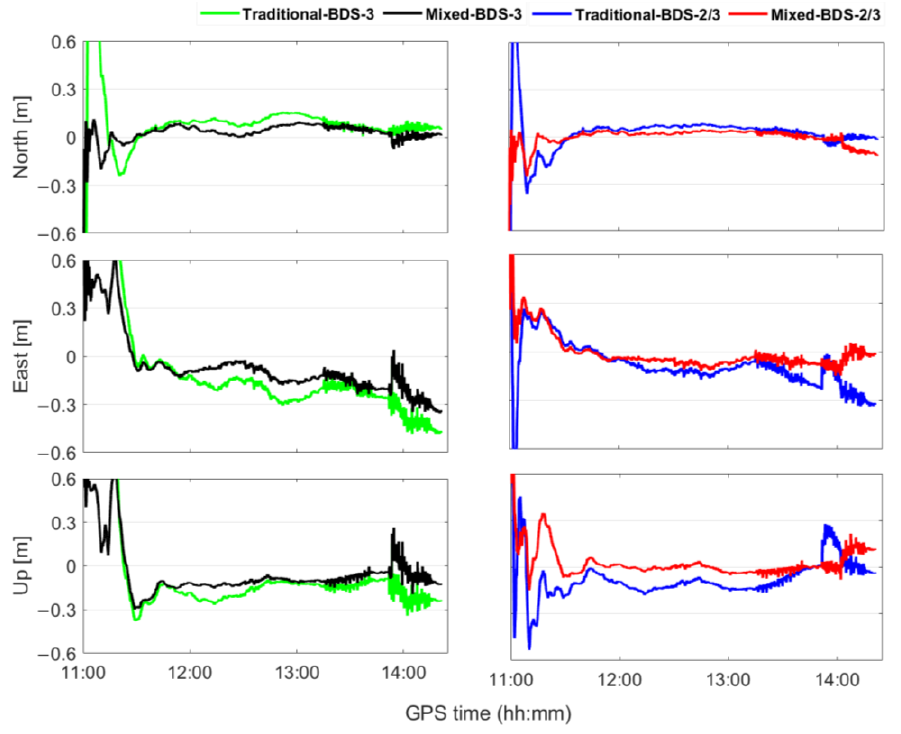
Figure 9. Number of satellites, number of carrier-phase observations and PDOP of kinematic PPP.